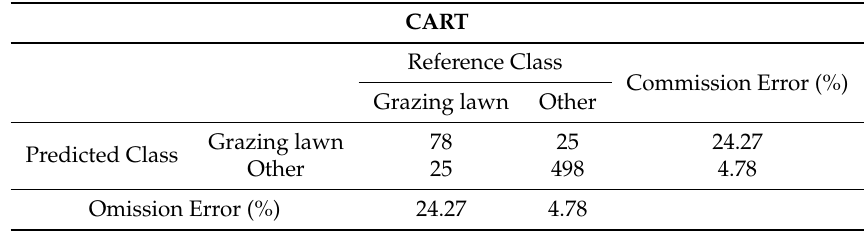
Table A8. Confusion matrix summarising results from Classification and Regression Trees (CART) model classification of grazing lawn and other cover.